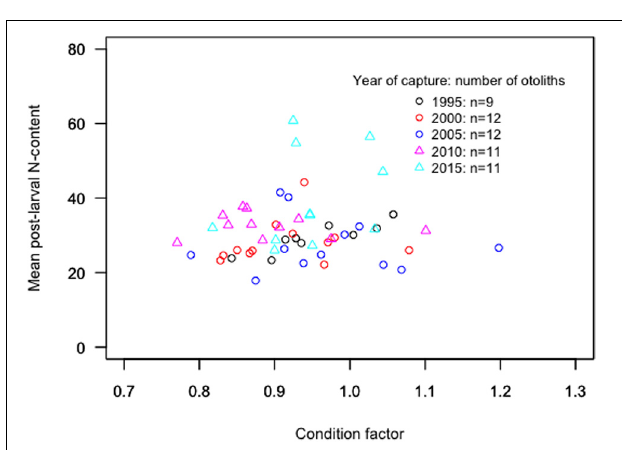
FIGURE 7 | The mean value of the post-larval N-content per otolith in relation to condition factor for all sampled